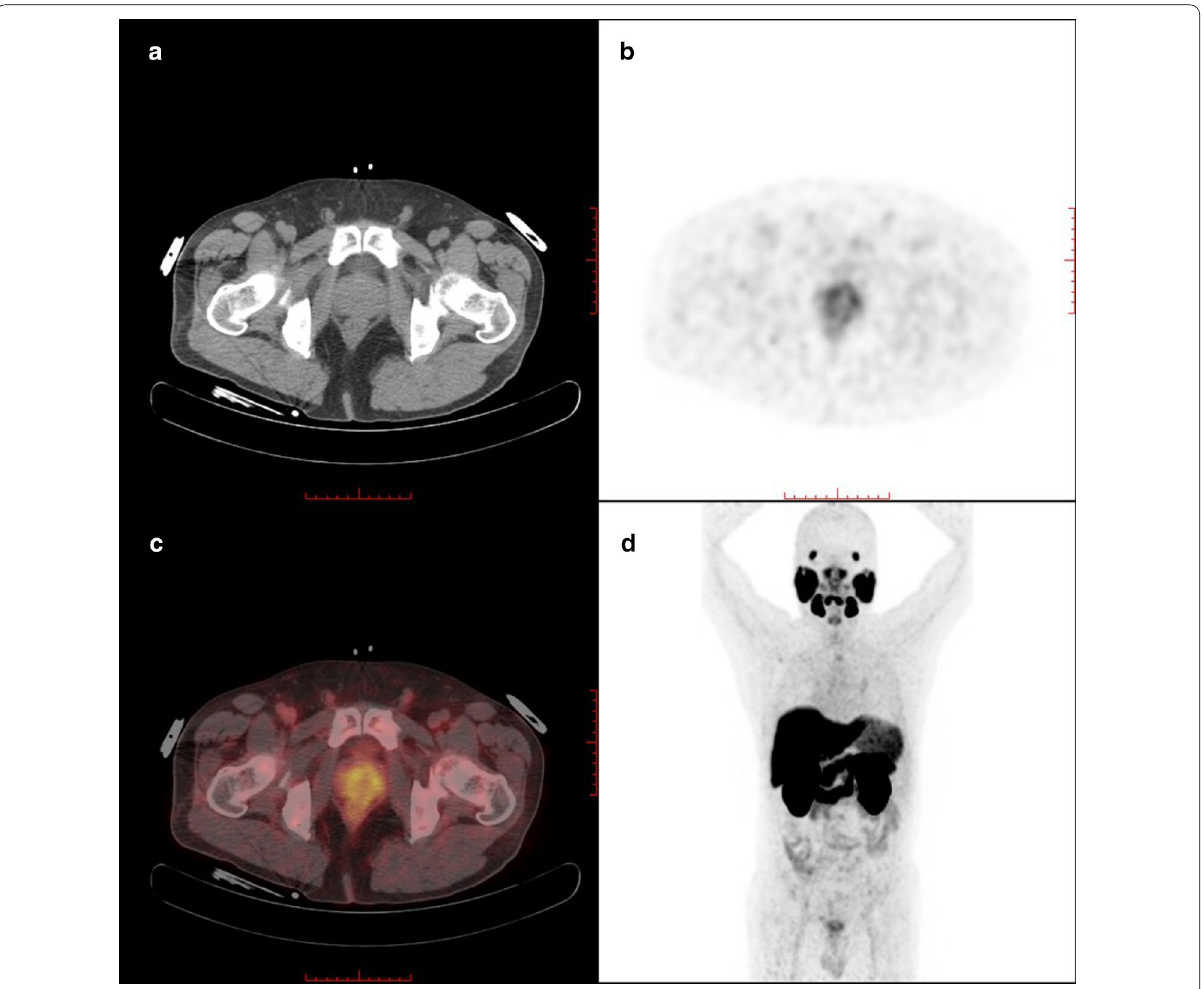
Fig. 2 18 F‑PSMA‑1007 PET/CT with CT ( a ), axial PET ( b ), and fused PET/CT ( c ) and maximum‑intensity projection ( d ) images of a 56‑year‑old patient (GS, 7a; PSA, 6.780 ng/ml). This patient was classified into IR group. Axial PET ( b ) and fused PET/CT ( c ) images showed light scattered 18 F‑PSMA‑1007 uptake in both sides of prostate gland (SUVmax: